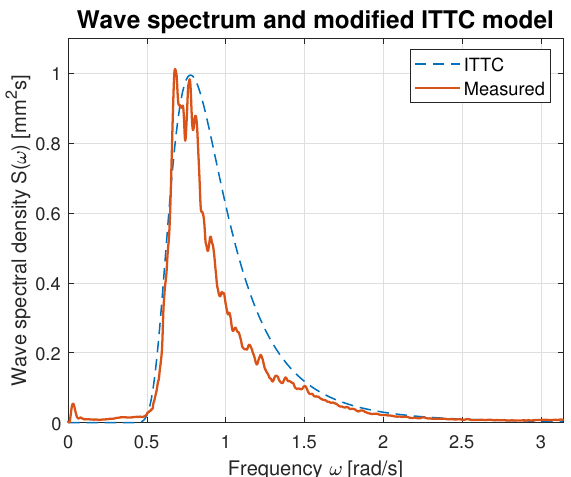
Figure 20. Comparison of the empirical wave spectrum evaluated for 9 BFT wind force in ship scale and the modified ITTC